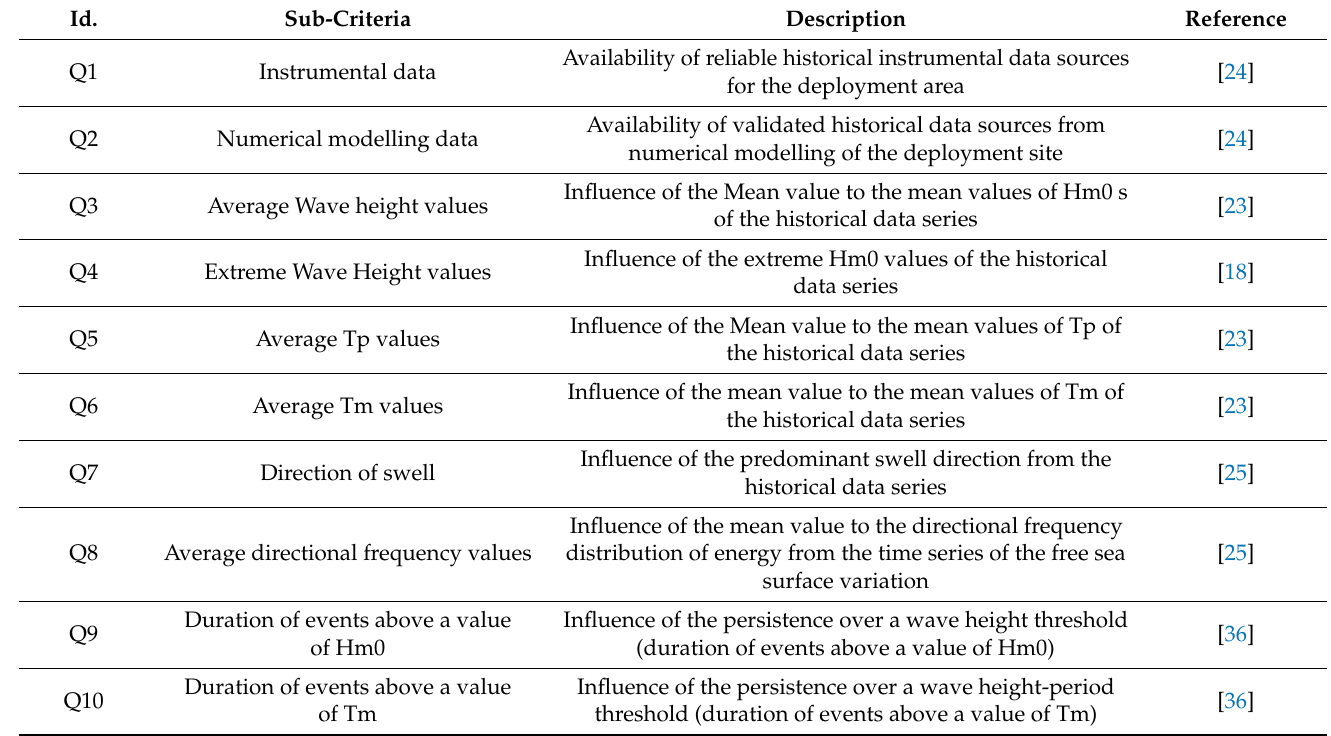
Table A2. Block 1: Influence of average climatic extremes on the choice of technology. Q1 to Q10.